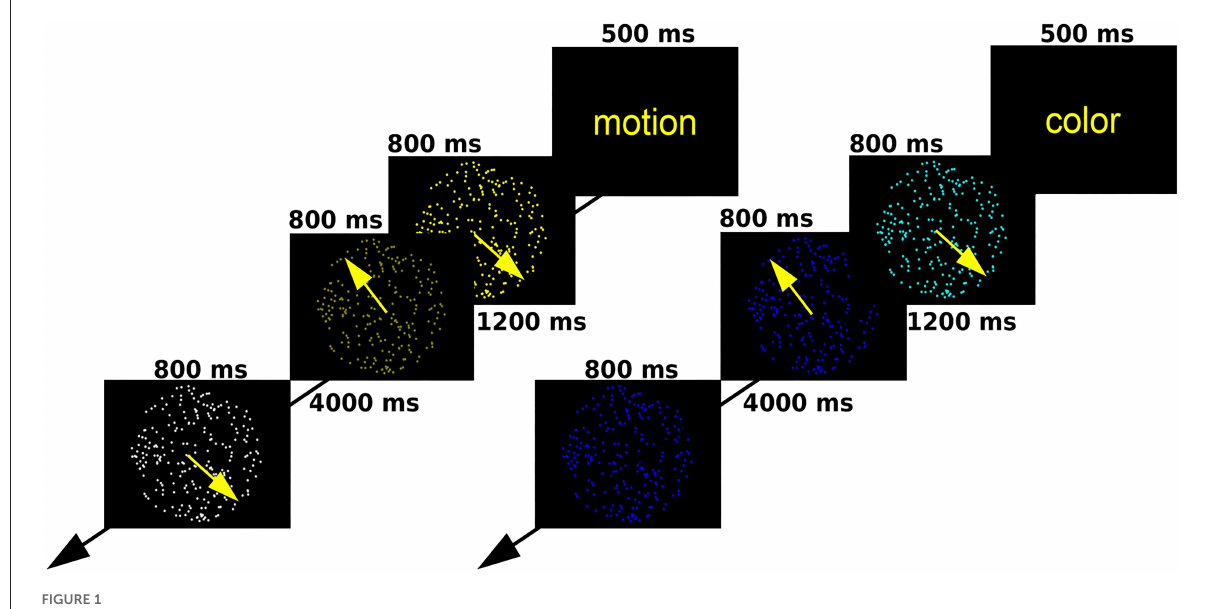
FIGURE1 A schematic outline of the moving dots task.